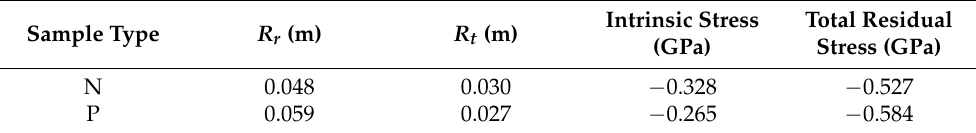
Table 1. Intrinsic and total residual stress generated during deposition and after TE optimisation via annealing, respectively, with R r and R t as the radius of curvature measured for the former and latter, based on the methodology described in the experimental